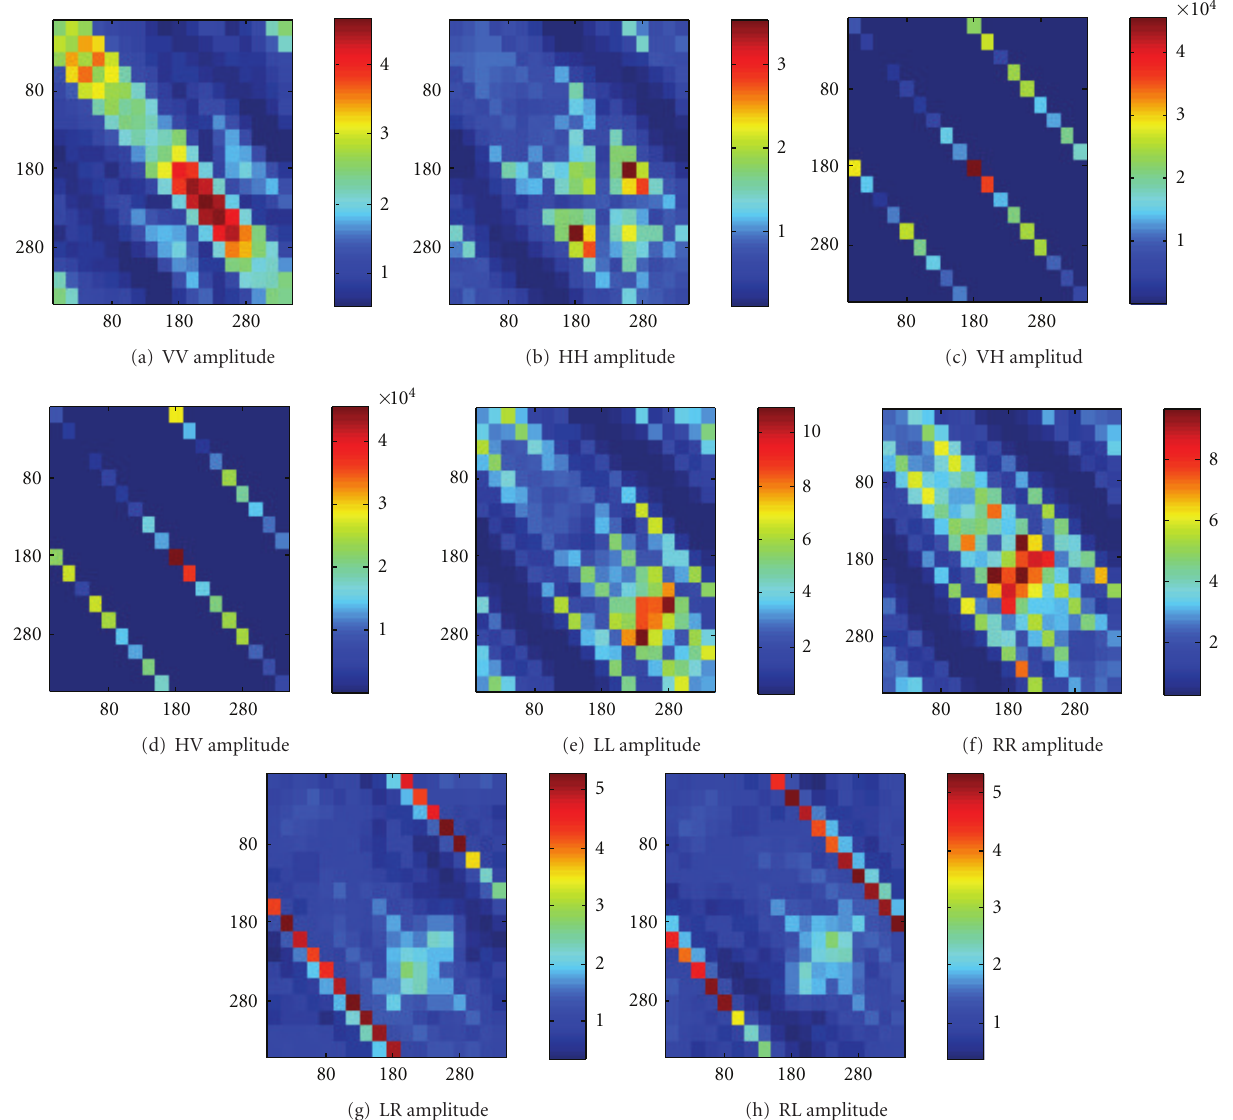
Figure 6: MD AB ,amplitude for di ff erent transmitter/receiver combinations. The comparison is made between the reference data (no tumor) with the case with 5 mm tumor with the dielectric properties given in Figure 3. (a) VV, (b) HH, (c) HV, (d)VH, (e) LL, (f) RR, (g) RL, and (h) LR. The vertical axis corresponds to the aspects of the incidence ( ϕ t = 0 ◦ to 340 ◦ ) and the horizontal axis corresponds to the aspects of the scattered far field ( ϕ r = 0 ◦ to 340 ◦